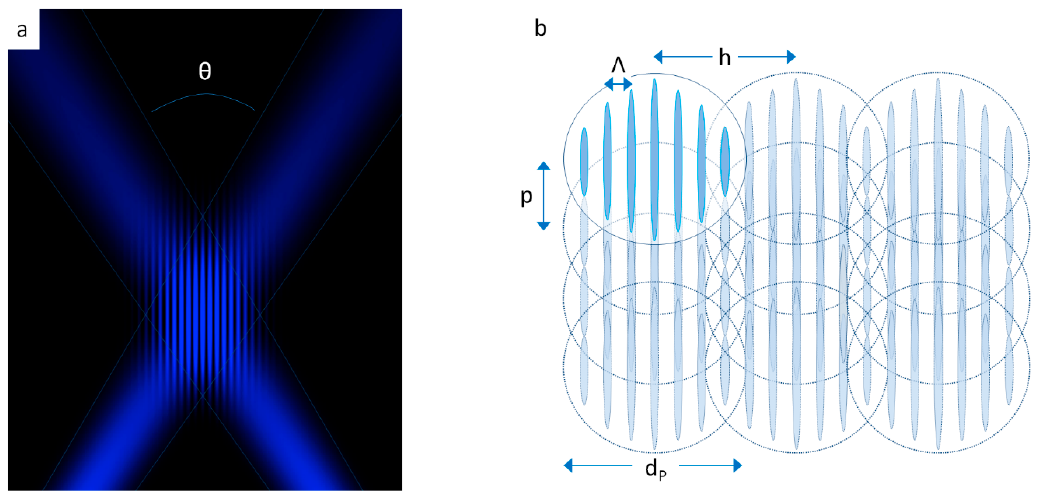
Figure 5. ( a ) DLIP interference pattern generated by two laser beams overlapping at an angle θ . ( b ) Scanning processing by displacement of multiple DLIP pixels. p : pulse (spot) separation, h : hatch distance; d p : DLIP pixel size; Λ : DLIP spatial period. The direction of scanning is